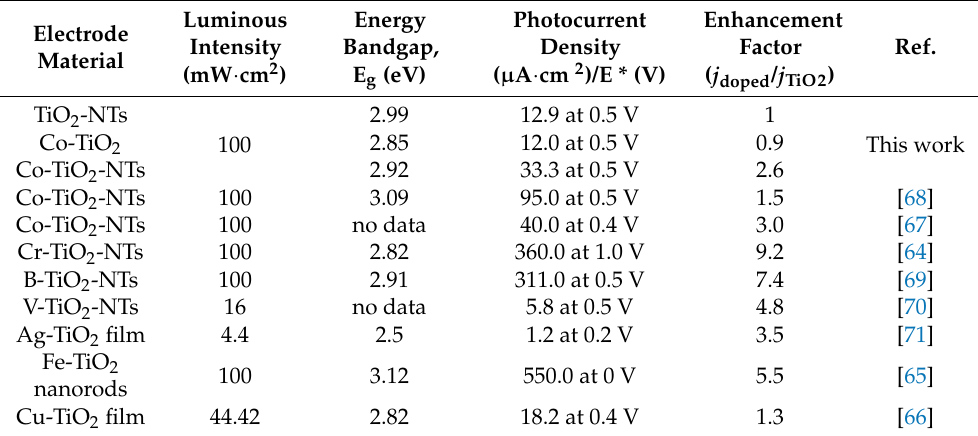
Table 4. Comparison of energy bandgap and photocurrent density for selected metal-doped TiO 2